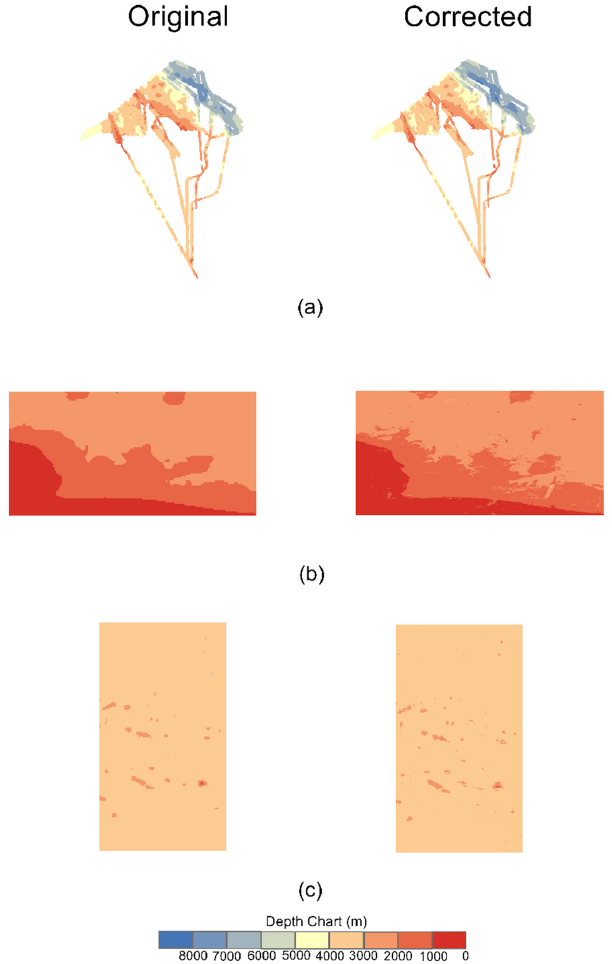
Figure 4. Bathymetric maps of ( a ) West Pacific, ( b ) Southern Ocean, and ( c ) East Pacific before and after correction.